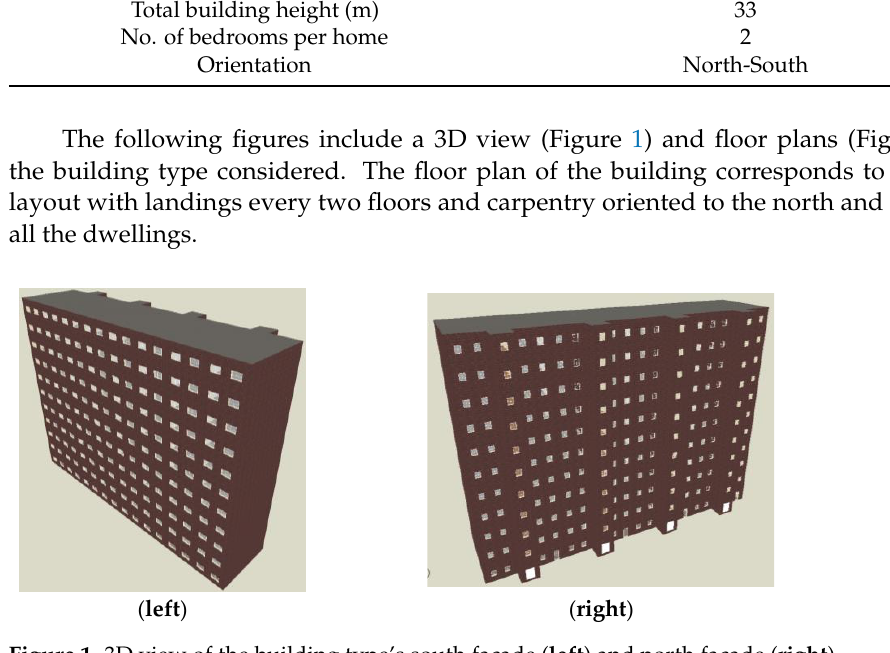
Figure 1. 3D view of the building type’s south façade ( left ) and north façade ( right ).